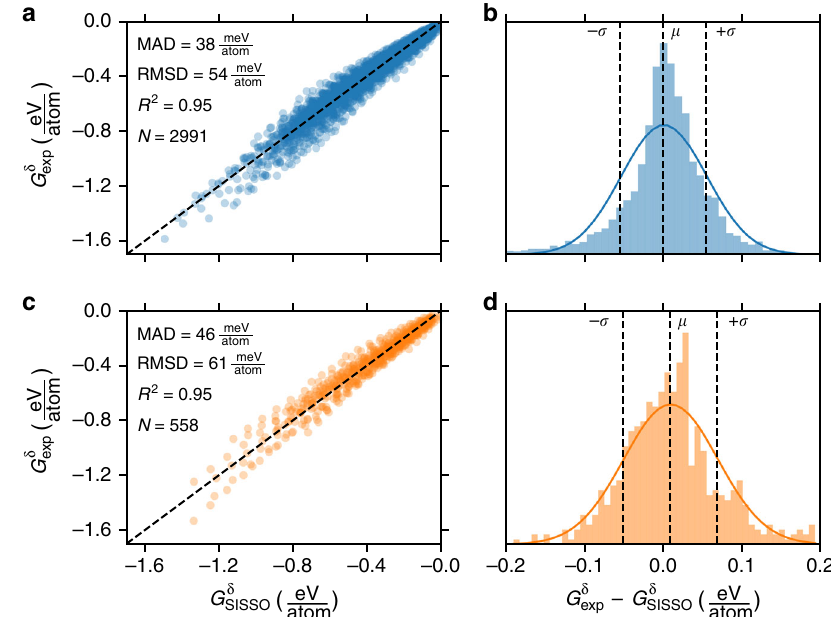
Fig. 2 Descriptor performance. a Performance of the SISSO-learned descriptor (Eq. 4) on the training set. b Distribution of residuals between the SISSO- learned descriptor and experiment on the training set. c Performance of the SISSO-learned descriptor (Eq. 4) on the test set. d Distribution of residuals between the SISSO-learned descriptor and experiment on the test set. MAD is the mean absolute deviation, RMSD the root mean square deviation, N the number of points shown, μ the mean deviation and σ the standard deviation. The curved lines are normal distributions constructed from μ and